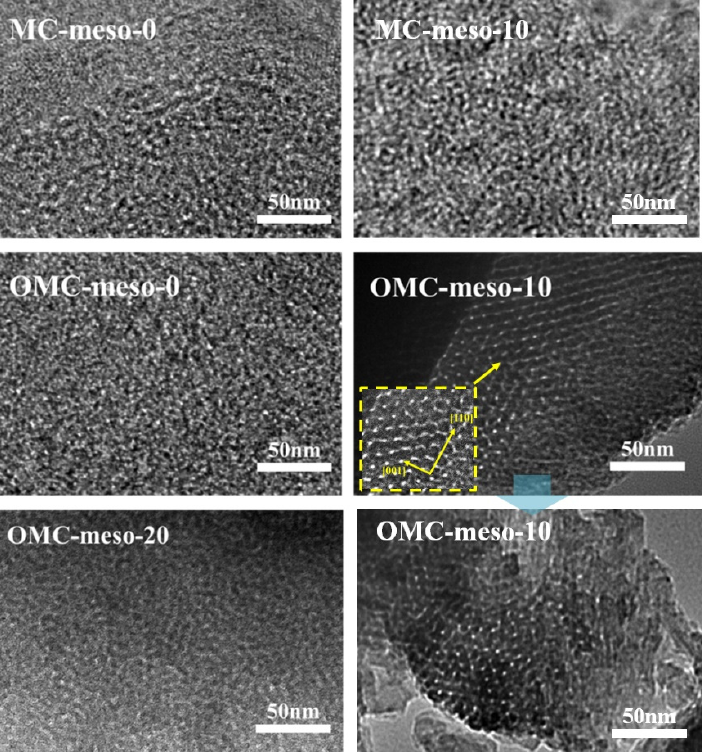
Figure 3. FE-SEM images of MCs and OMCs prepared with different amounts of mesophase pitch.